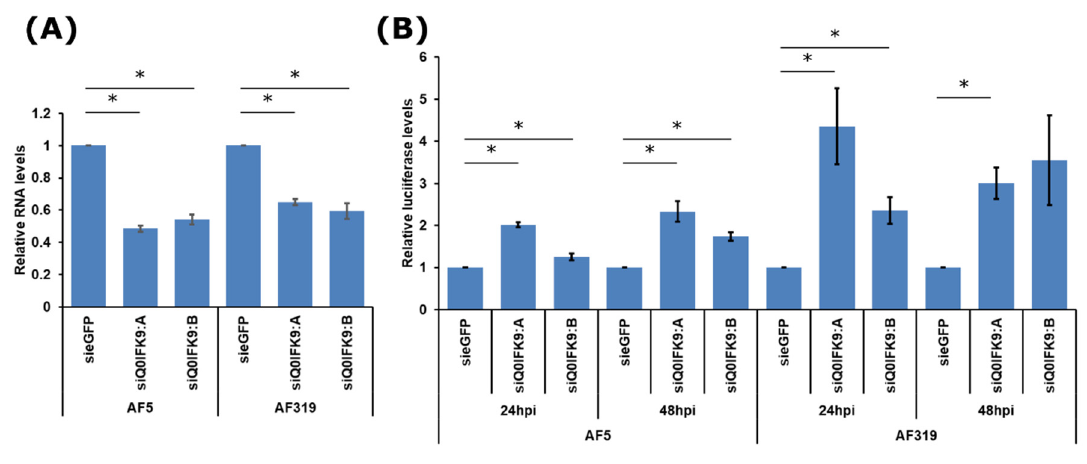
Figure 5. E ff ects of Q17D57and Q0IFK9 knock down on SFV replication in Dcr2 knockout cells. ( A ) AF5 and AF319 (Dcr2 KO) cells were transfected with two di ff erent siRNAs against Q0IFK9, or siRNA against eGFP as control; knock down e ffi ciency was assessed at 24 h p.t. by qRT-PCR with S7 as housekeeping gene. The mean values of four independent experiments with standard error are shown. ( B ) At 24 h p.t. with siRNAs as shown, AF5 or AF319 cells were infected with SFV(3H)- FFLuc at MOI 0.01 and luciferase levels were assessed 24 and 48 h p.i., for each cell line. Luciferase values of sieGFP treated cells was taken as 1 per time point for each cell line; the standard error of the mean from three experiments conducted in triplicate are shown. For statistical analysis, to reduce heterogeneity, log-transformed values in ( B ) were used; * indicates significance, p < 0.05 (Student’s two-tailed t -test).